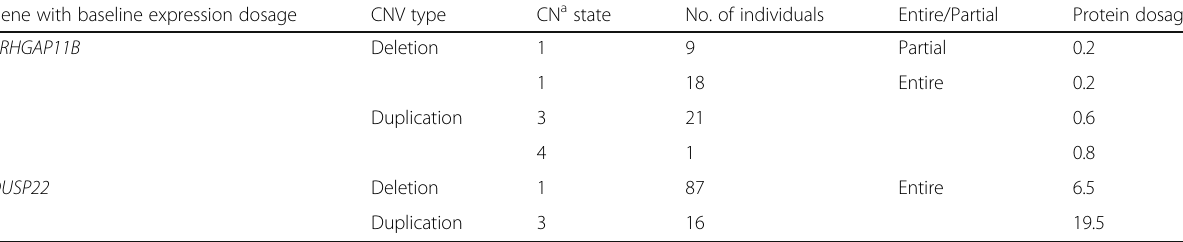
Table 2 Baseline expression dosage of ARHGAP11B and DUSP22 in the brain using Human Gene Atlas Gene with baseline expression